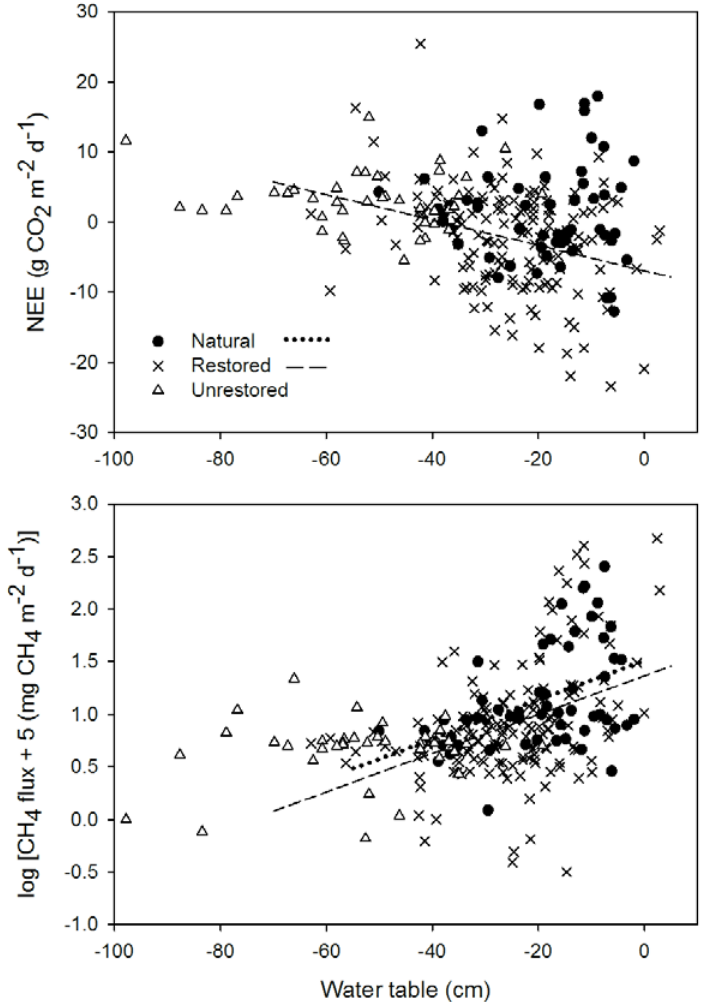
Figure 4. Net ecosystem exchange of carbon dioxide (CO 2 ; NEE; top) and methane (CH 4 ) flux (bottom) versus water table (WT) position. NEE fluxes (g CO 2 m -2 d -1 ) were measured when photon flux density of photosynthetically active radiation was greater than 1000 µmol m -2 s -1 . Negative values indicate uptake of CO 2 by the ecosystem. Regression lines are plotted for each restoration class when statistically significant. Regression equations are: top) restored: NEE = -0.18(WT) – 6.91, bottom) natural: log(CH 4 + 5) = 0.019